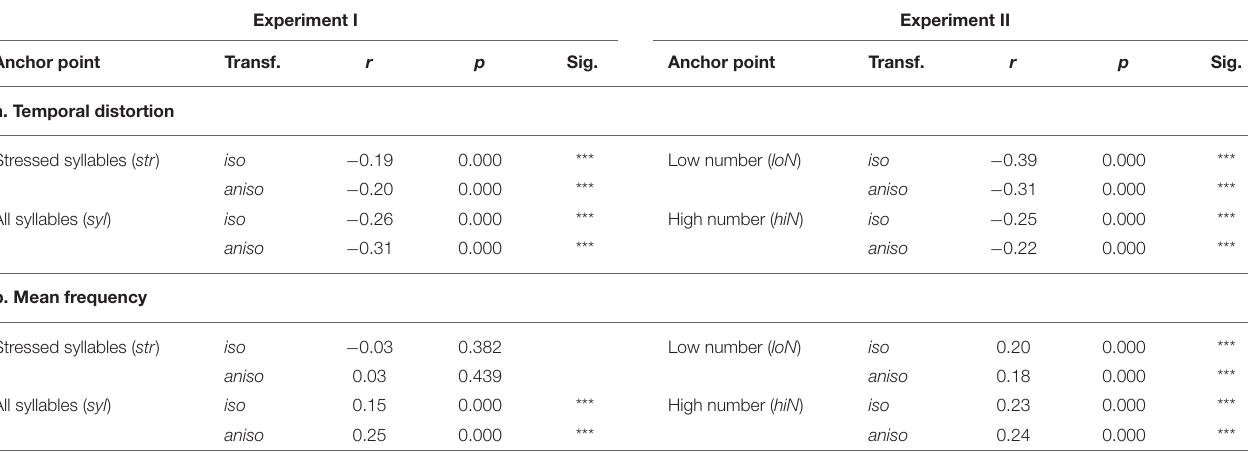
TABLE 2 | Correlation between intelligibility scores of transformed sentences and a. Temporal distortion; b. Mean frequency for both Experiments across all subjects. Experiment I Experiment II Anchor point Transf. r p Sig. Anchor point Transf.